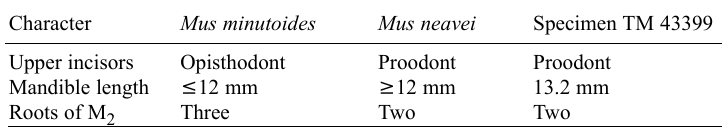
Diagnostic characters distinguishing Mus neavei from Mus